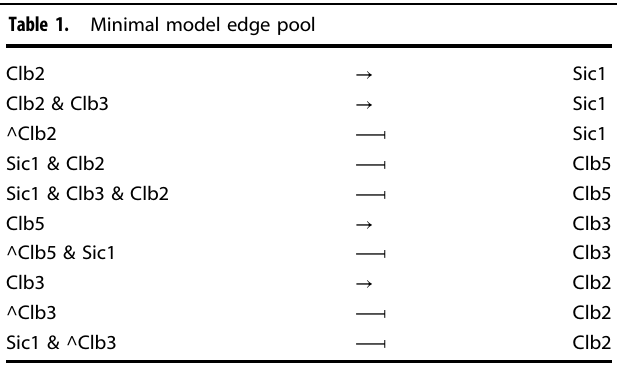
Fig. 5 Expected oscillations in the Clb cyclin network and de fi nition of Boolean attractor candidates. a Minimal prior knowledge network (PKN) encompassing the interactions among Clb5 ( red ), Clb3 ( blue ), Clb2 ( green ), and their inhibitor Sic1 ( black ). Known interactions are indicated with solid lines . 12 For the newly unraveled interactions, both potential activatory and inhibitory regulations are considered: interactions mimicking positive regulations of an early Clb/Cdk1 complex on the next one through the Fkh2 transcription factor are indicated with solid red lines ; interactions mimicking negative regulations of an early Clb/Cdk1 complex on the next one through the Fkh2 transcription factor are indicated with dashed black lines . b Boolean modeling strategy. Novel and known interactions occurring among Clbs and Sic1 were implemented in the models, which were then fi ltered for the expected attractors (by using GenYsis) and for the expected curves (by using SQUAD). The collection of minimal models reproducing the experimental observations was then validated by using a different qualitative strategy (MaBoSS). c Minimal candidate models reproducing experimental Clb and Sic1 waves and satisfying CLB2 overexpression experiments. 27 The minimal models 2 and 3 satisfy the known experimental conditions (wild type, SIC1 overexpression and sic1 Δ ) by both Boolean simulations (GenYsis) and standarized ODE simulations (SQUAD). Arrows and circles denote activations and inhibitions, respectively. d SQUAD simulations of CLB2 overexpression experiments for the minimal model 2. From top to bottom are plotted simulations of an increase dosage of Clb2: 1 ( upper panel ), 5 ( mid panel ), and 30 ( bottom panel ). The insert in the bottom panel represents a magni fi cation of Sic1, Clb5, and Clb3 oscillations when Clb2 is set to 30. It shall be noted that by the computational time t = 15 the cycles are progressively reduced when increasing the Clb2 level. The results are in agreement with the experimental observations. 27